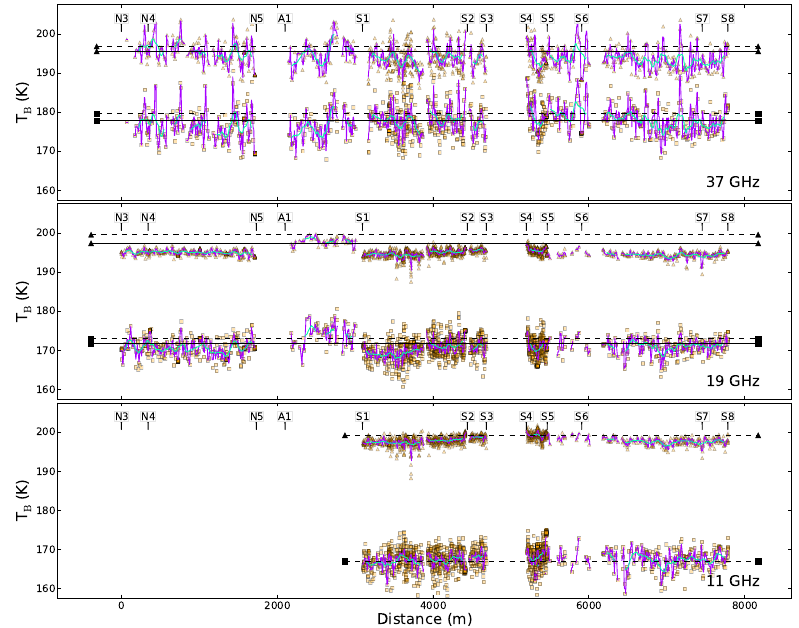
Figure 8. Brightness temperature measured along the N3–N4 (25 January), A1–S1 (26 January) and S1–S8 (31 January) transects for three frequencies (11, 19 and 37GHz) and nearly constant incidence angles (52 and 57 ◦ ). The symbols represent individual measurements at vertical polarization (triangles) and horizontal polarization (squares). The solid curves, violet and blue, show the running average with a box window of 20 and 200m respectively. The horizontal black lines show the mean brightness temperature during the campaign for the pixel including Dome C from SSM/I (solid line) and WindSat (dashed